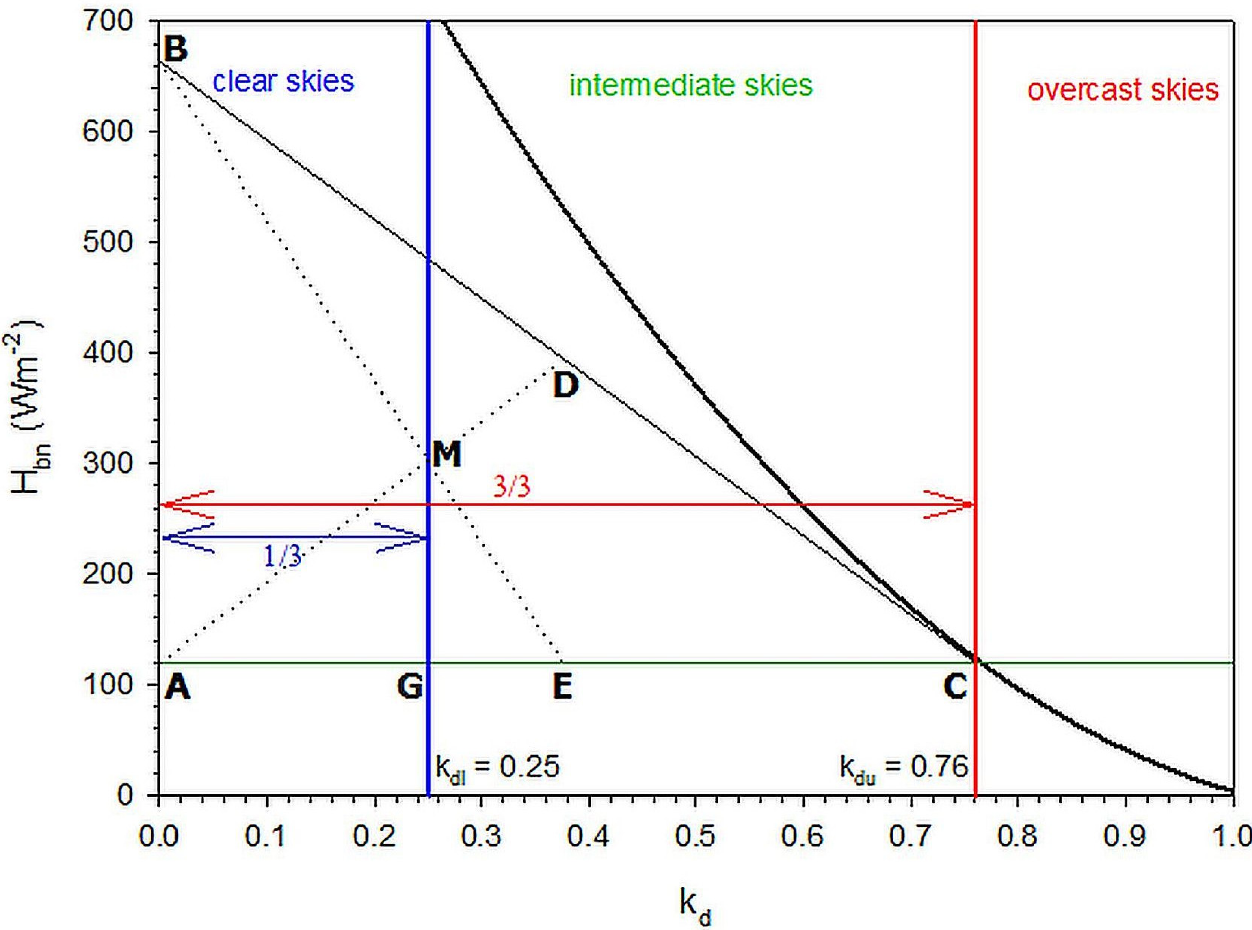
Figure 2. Mathematical determination of the upper (k du , red solid line) and lower (k dl , blue solid line) limits of k d that divide the skies into clear, intermediate, and overcast. The bold black solid line is the best-fit curve to the H bn -k d data points that correspond to their hourly values; in this case the typical meteorological month of January, which belongs to the PV-GIS TMY-BOU, has been considered. The line BC is tangent to the best-fit line at C (0.76,120). M is the crossing point of the medians AD and BE. The MG line is normal to AC. From the Euclidian geometry AG = AC/3 in the rectangle triangle ABC; therefore, k dl = k du /3 = 0.76/3 ≈ 0.25.